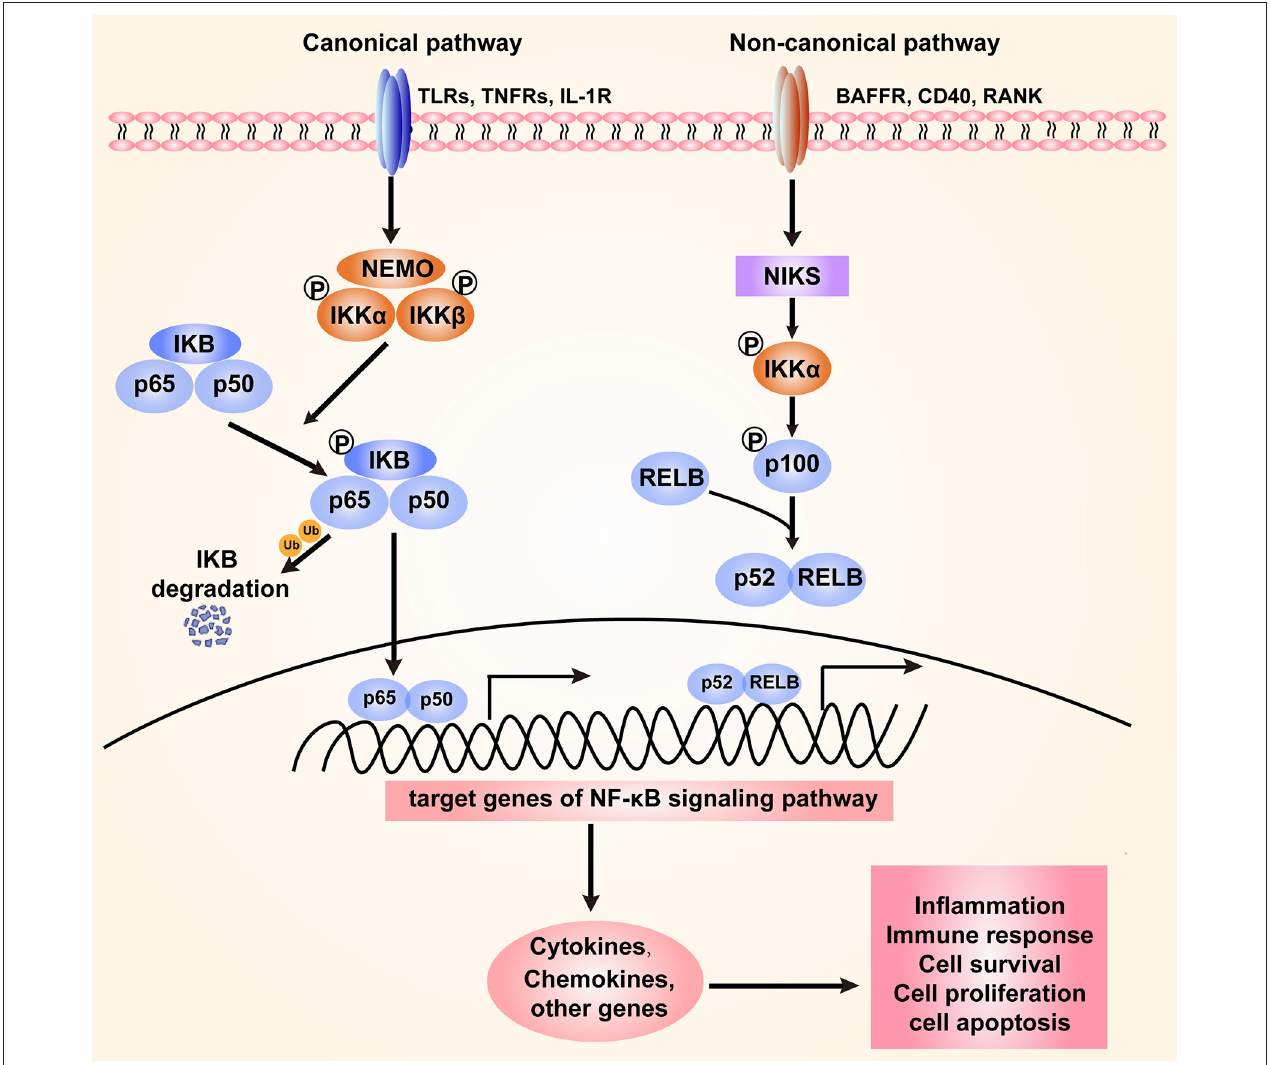
FIGURE 1 | The canonical and non-canonical NF- κ B signaling pathway. The canonical pathway is induced by TLRs, TNFRs, and IL-1R. Activation of this cascade leads to the phosphorylation and degradation of inhibitory protein I κ B. NF- κ B is activated by release from the I κ B-containing complex, then translocating into nucleus. The non-canonical pathway is dependent on the activation of NF- κ B2 (p100)/ RelB complex by BAFFR, CD40, and RANK. This cascade induces phosphorylation of NIK, which subsequently phosphorylates IKK α . Then p52-RelB heterodimer is activated and translocate to the nucleus. The activation of NF- κ B signaling regulates various cellular processes through targeting the expression of cytokines, chemokines and other